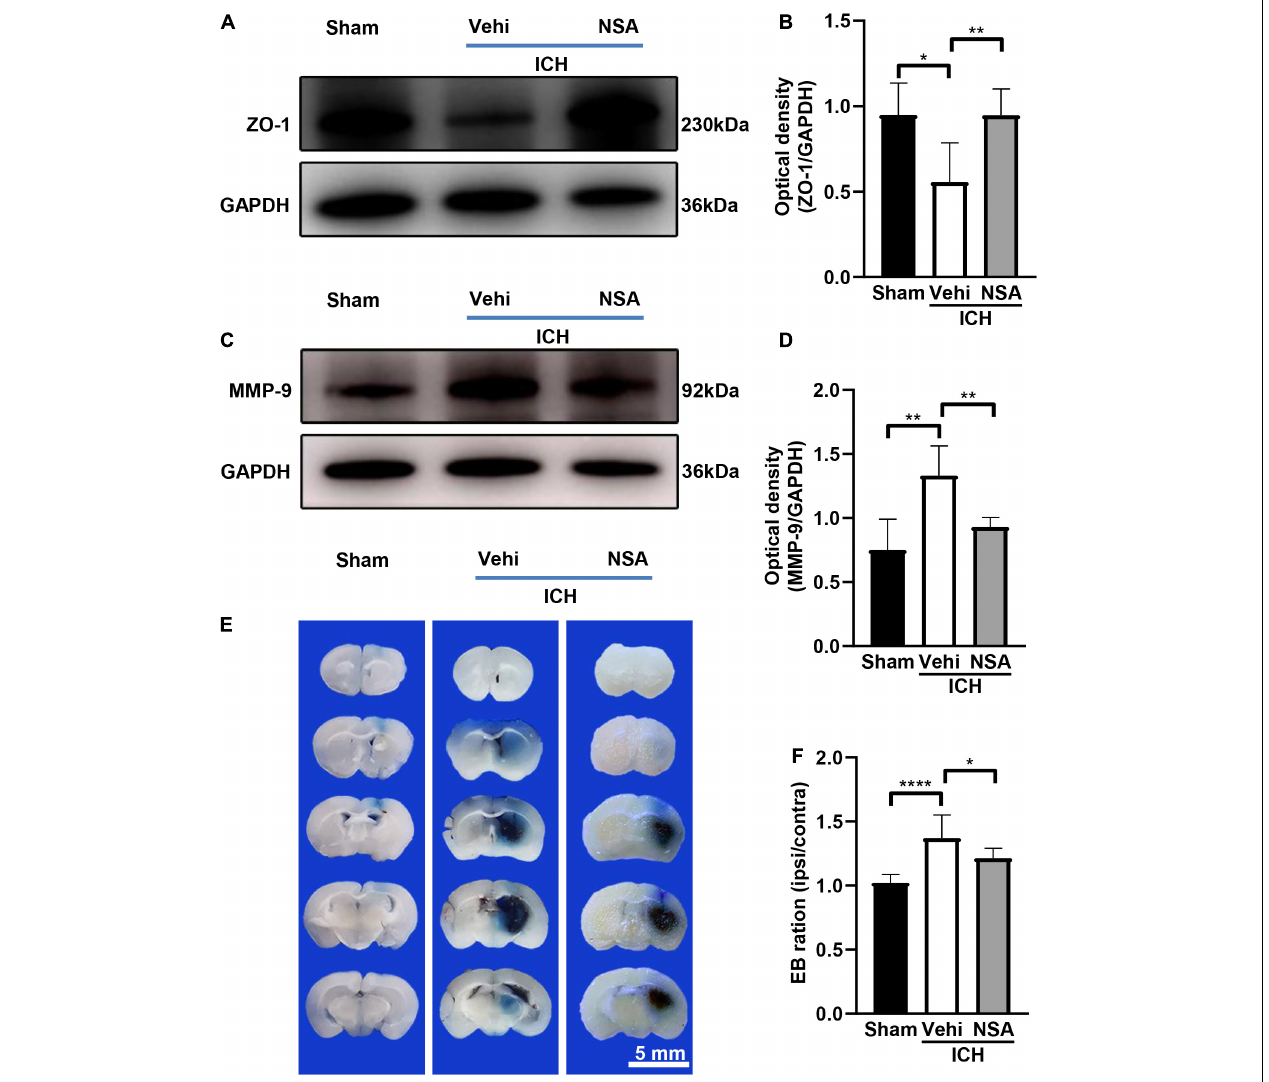
FIGURE 5 | The effect of necrosulfonamide (NSA) on blood-brain barrier permeability in mice after intracerebral hemorrhage (ICH). (A) Representative western blotting images of the expression of ZO-1 at 3 days after ICH. (B) Quantification shows that NSA increased the expression of ZO-1 ( n = 3, per group). (C) Representative western blot images of the expression of MMP-9 at 3 days after ICH. (D) Results show that NSA decreased the expression of MMP-9 ( n = 3, per group). (E) Representative images of Evans blue dye leakage at 3 days after ICH. (F) Evans blue leakage at 3 days after ICH ( n = 10, per group). Data are shown as mean ± SD; scale bar = 5 mm; * p < 0.05, ** p < 0.01, **** p <